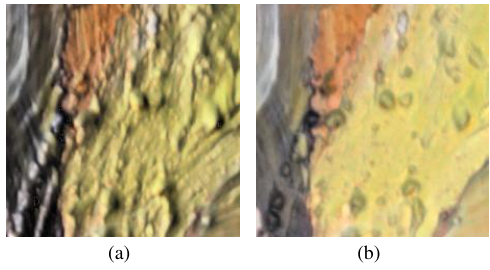
Figure 5. (a) Cropped data of RTI (b) Cropped data of Non-RTI result shows that the accuracy of the model which learned the depth-visualized data is 4.48% higher.